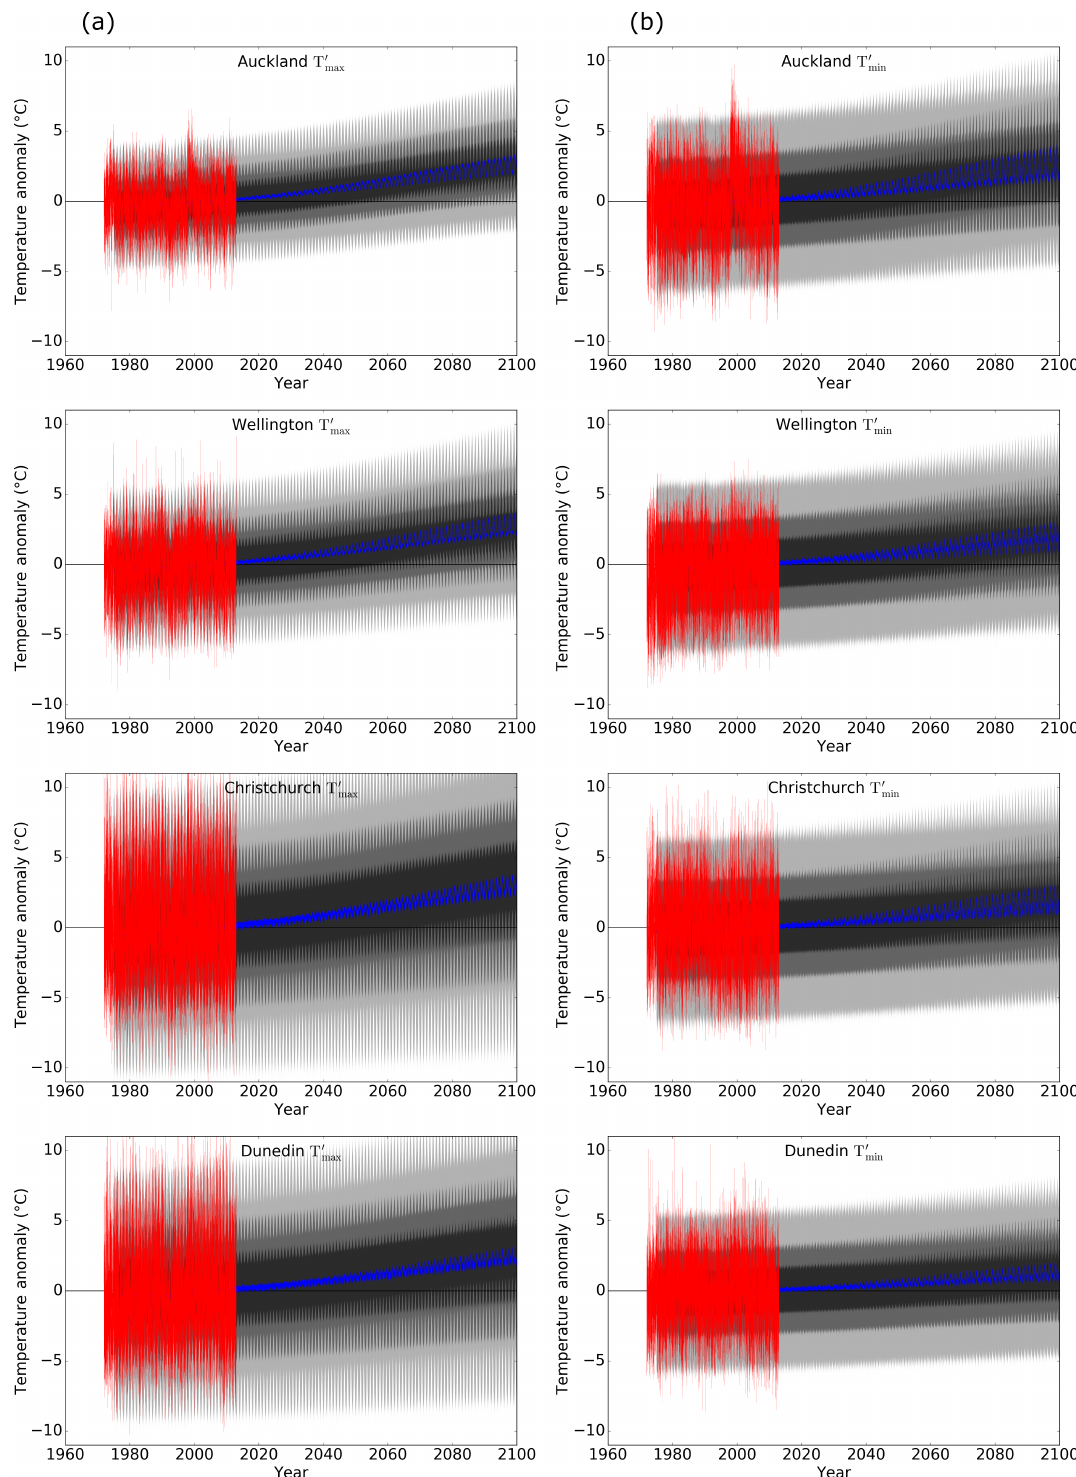
Figure 8. Example output from 1900 EPIC-generated time series for Auckland, Wellington, Christchurch and Dunedin from 1960 to 2100 under the RCP8.5 GHG emissions scenario. Grey shaded areas show the 1, 10, 25, 75, 90, and 99 percentiles while the blue line shows the median value on each day. The T (cid:48) max (left column) and T (cid:48) (right column) anomalies are with respect to the 2000–2010 mean annual cycle. min VCSN time series are overlaid in each panel (red